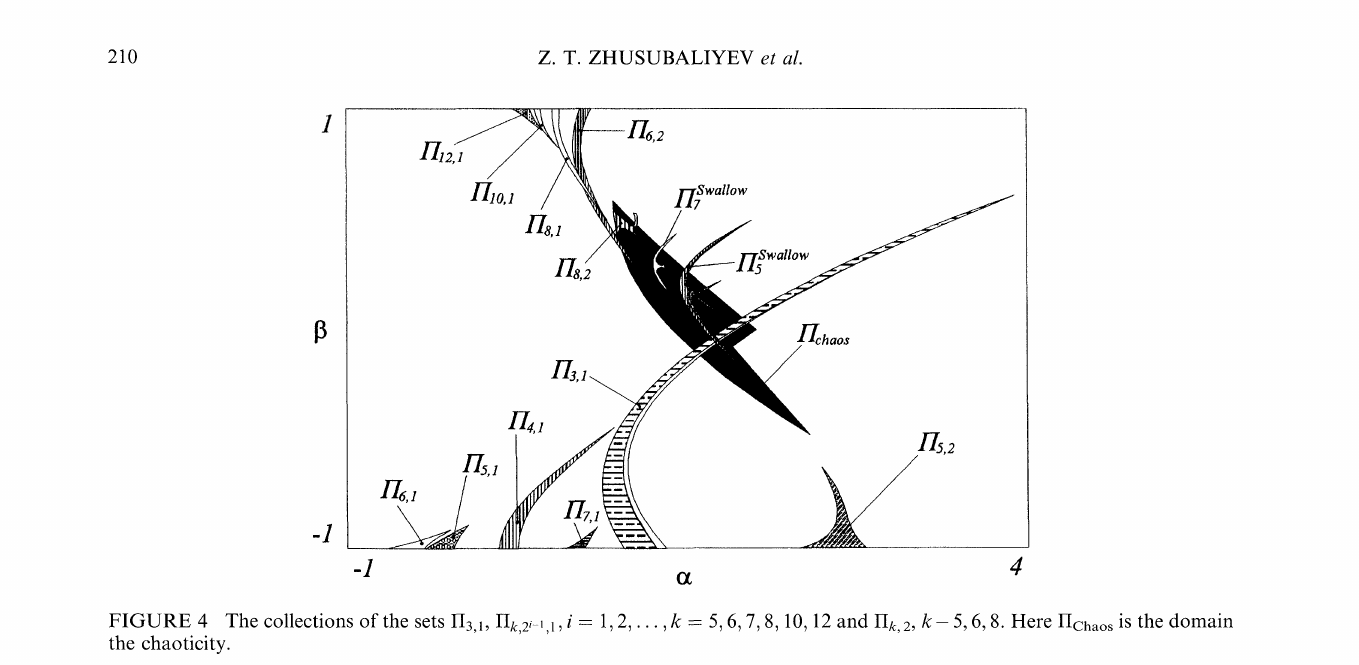
FIGURE 4 The collections of the sets ]-I3,1, Ik,2i-,,l,i 1,2,... ,k